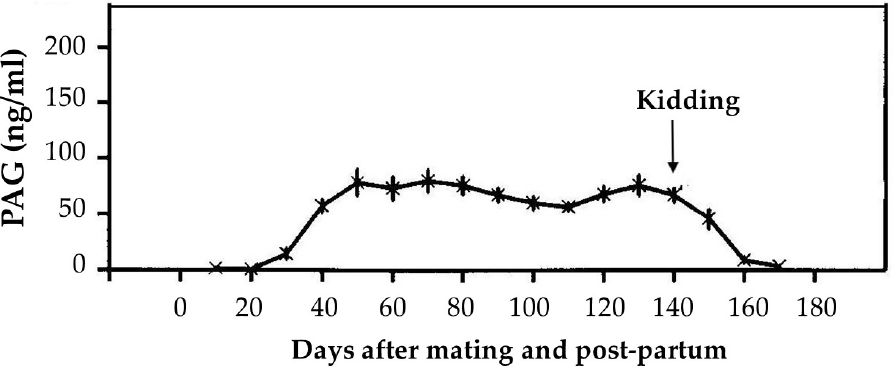
Figure 4. Pregnancy-associated glycoprotein (PAG) plasma profile during pregnancy and post-partum in goats. Adapted from Zarrouk et al. [94].